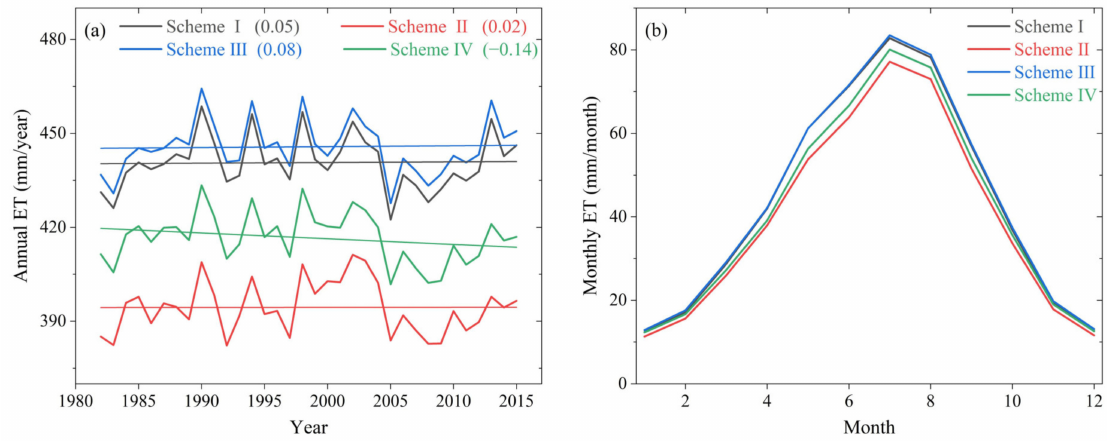
Figure 6. The interannual change ( a ) and seasonal cycle ( b ) of national average ET estimates under four vegetation input schemes from 1982 to